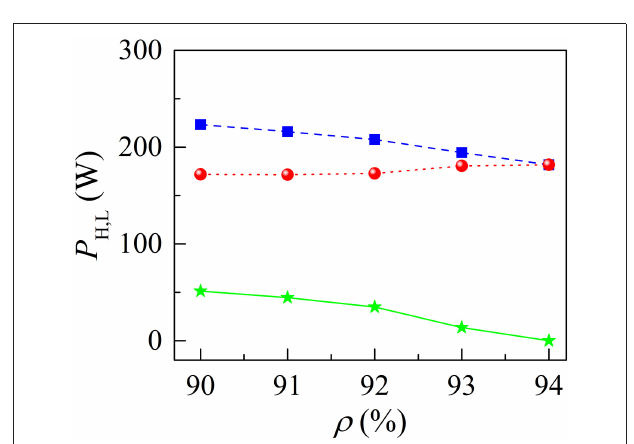
FIGURE 6 | The P H and P L values vs. L . Their difference as a function of L is shown by the solid green